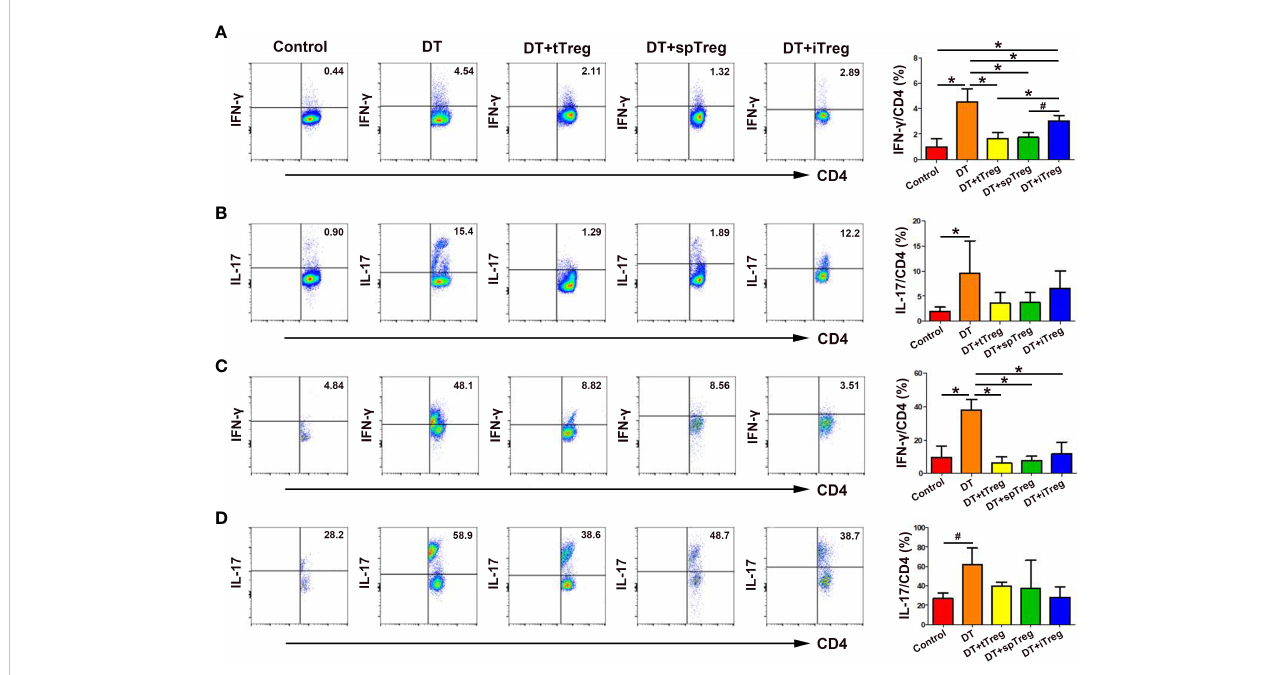
FIGURE 7 Effects of adoptive transfer of Treg cells on peripheral blood and decidua Th1 and Th17 cells in DT-treated Foxp3 DTR mice. Representative fl ow cytometry experiments and levels of IFN- g (A) and IL-17 (B) on peripheral blood CD4 + T cells are shown. Representative fl ow cytometry experiments and levels of IFN- g (C) and IL-17 (D) on decidua CD4 + T cells are presented. Data are presented as mean ± SD (n = 6). * p < 0.01, # p <